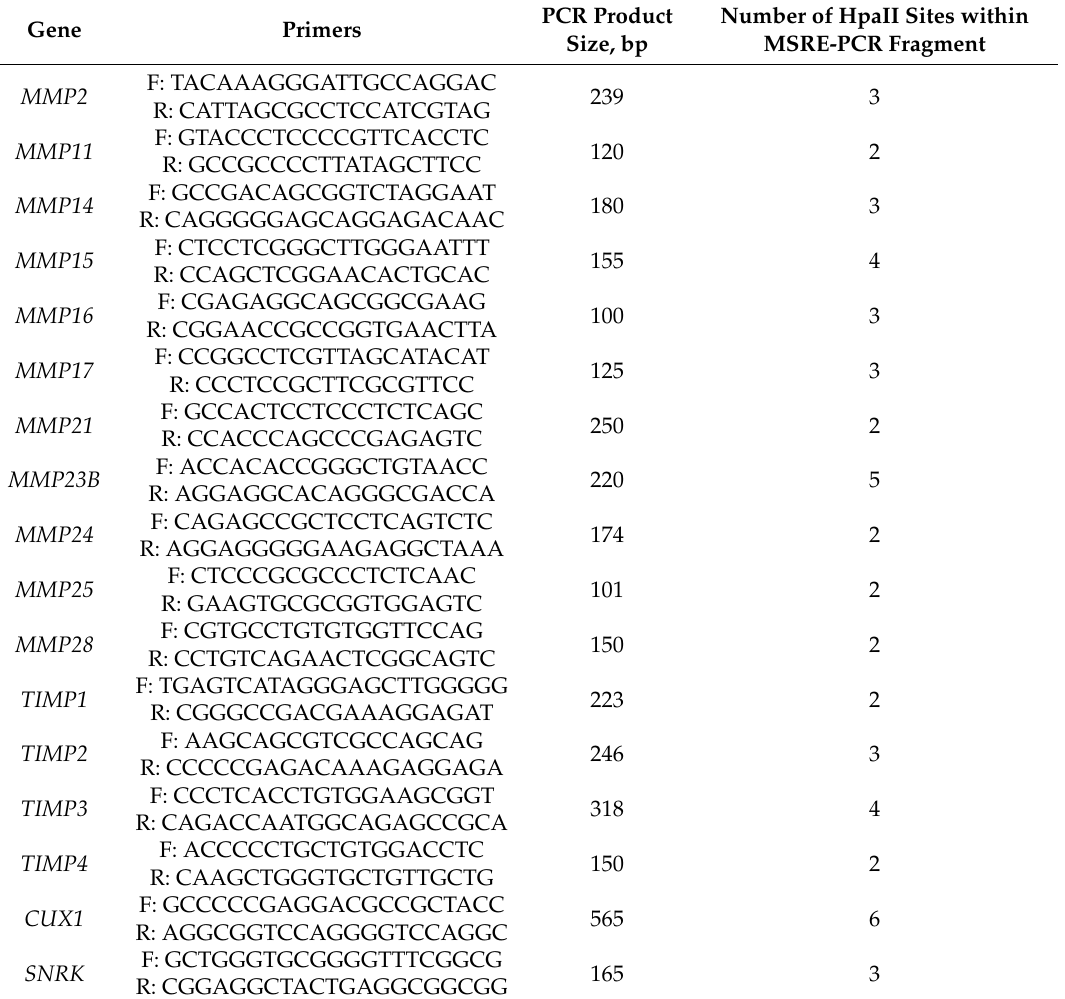
Table 1. Primers used to assess the methylation status of the MPP and TIMP genes by methylation-sensitive restriction enzyme digestion